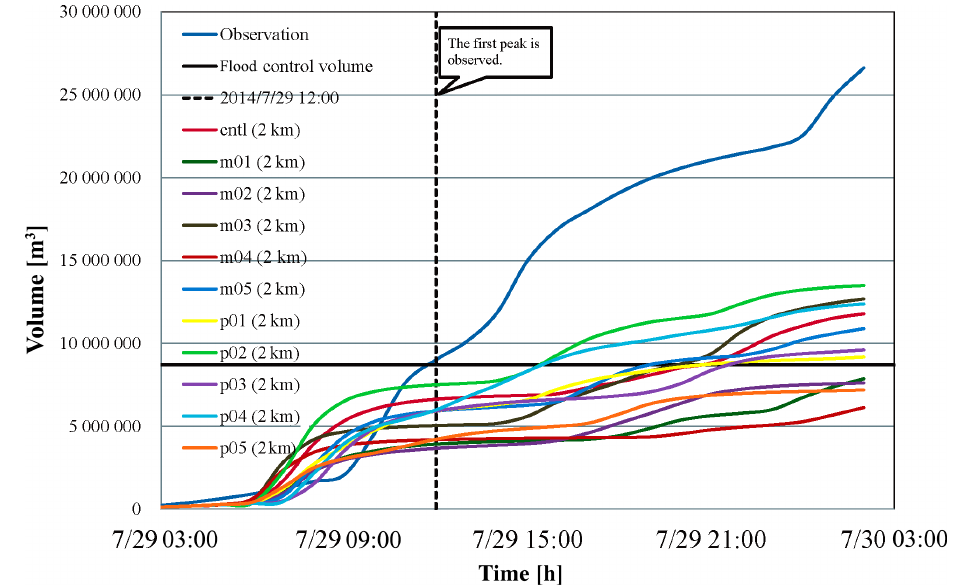
Figure 15. Inflow volume into the reservoir based on observation and 2km ensemble simulations.